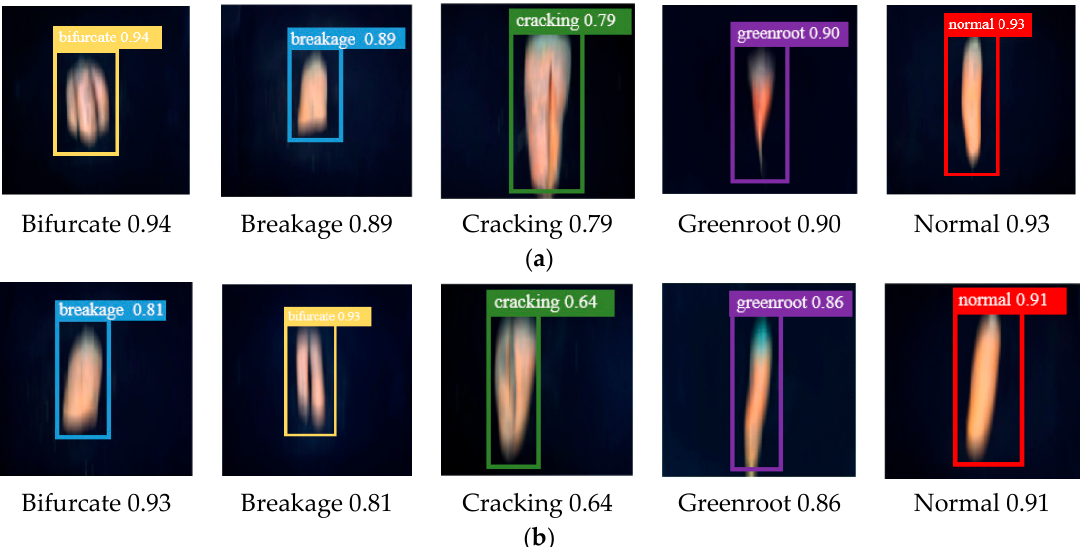
Figure 12. Identification result graph. ( a ) Part identification results of Datase t(S); ( b ) part identifi- cation results of Dataset (S 1 ).